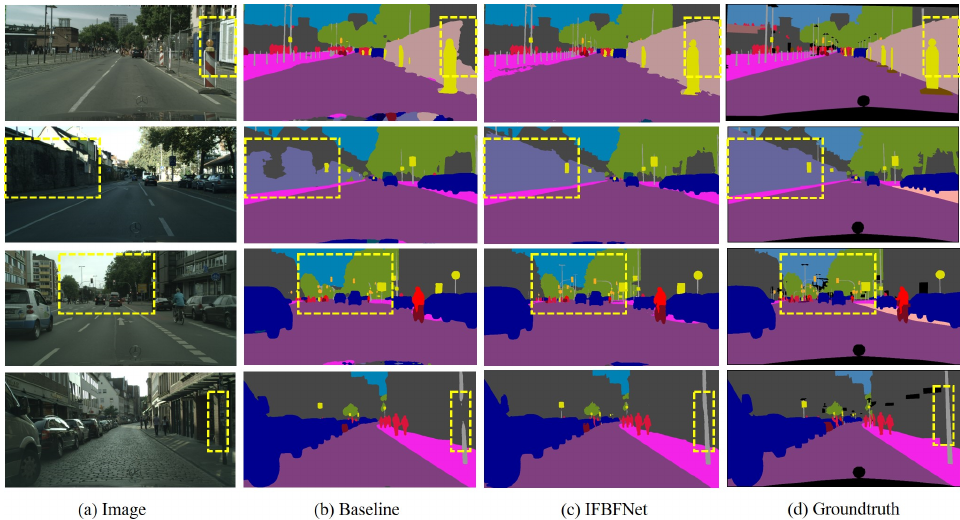
Figure 6. Visualization results of IFBFNet based on ResNet101 baseline on the Cityscapes valida- tion